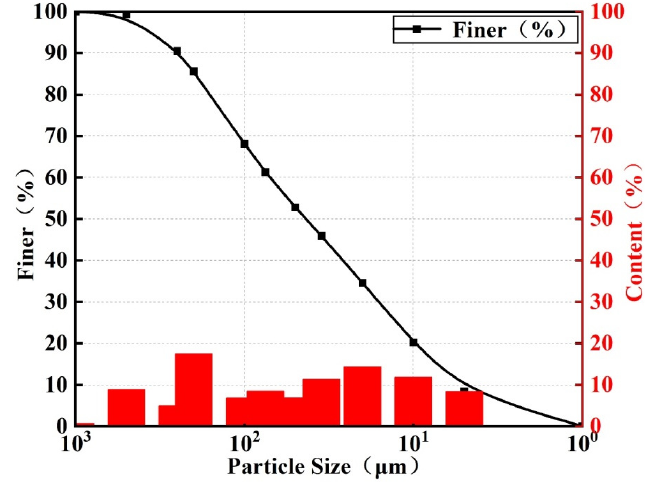
Figure 1. Particle size distribution curve of Pb–Zn tailings. Table 1. Chemical compositions of fly ash and cement.